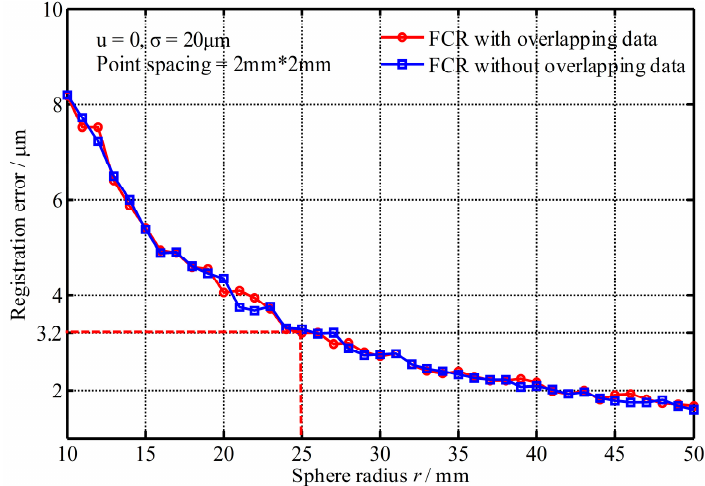
Figure 5. Registration errors changed with the sphere radius.